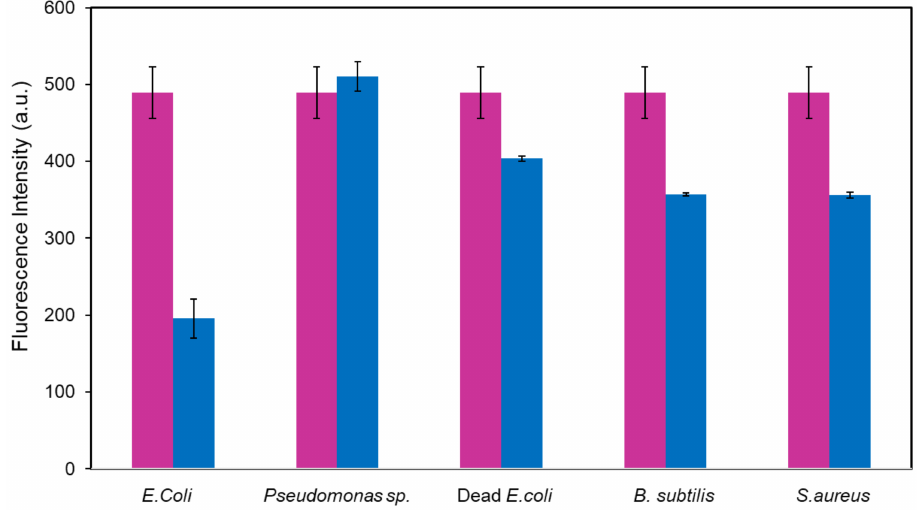
Figure 6. Comparison of fluorescence intensities of SNP-RB, before (pink) and after incubation with bacteria (blue). The error bars were obtained after conducting three separate